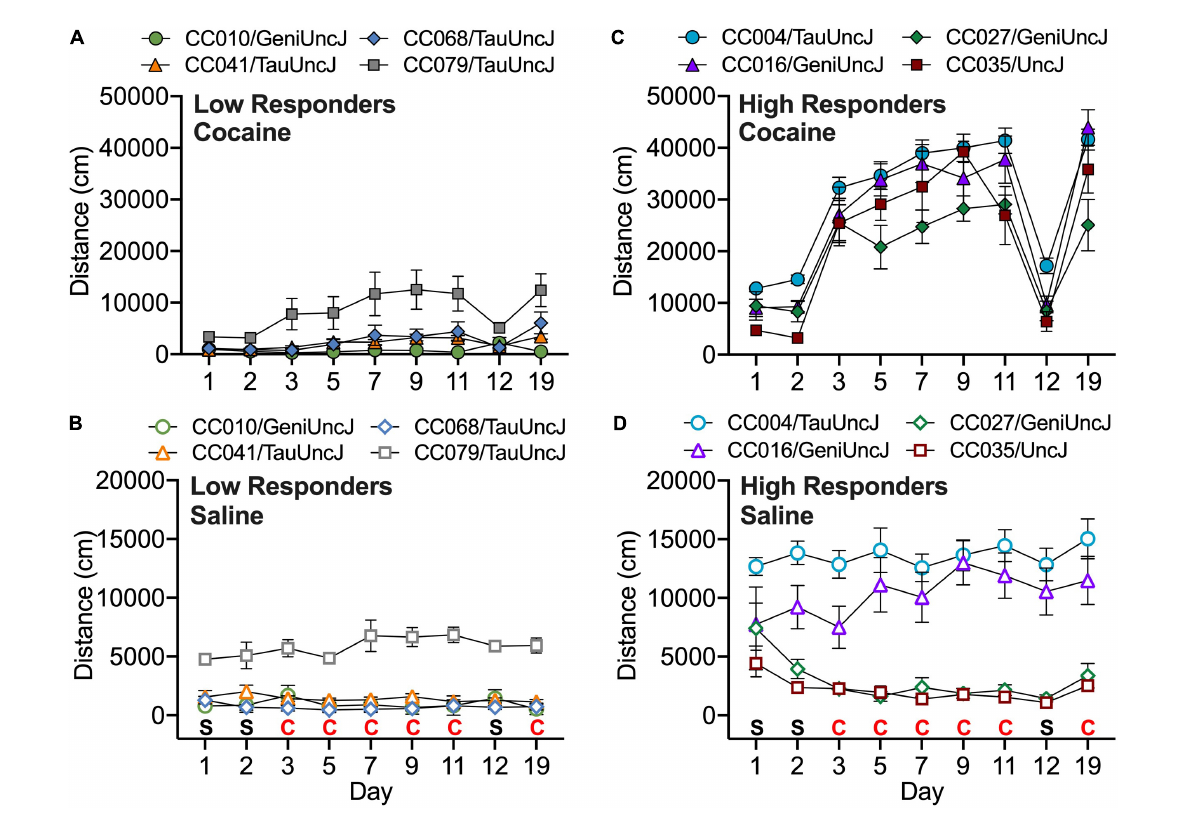
FIGURE1 Strain means across the 19-day protocol are shown for Collaborative Cross strains with the lowest (A) and highest (C) responses to 10 mg/kg cocaine (filled symbols). Response to saline exposure in the same strains is shown in (B,D) (open symbols). Error bars are standard error of the